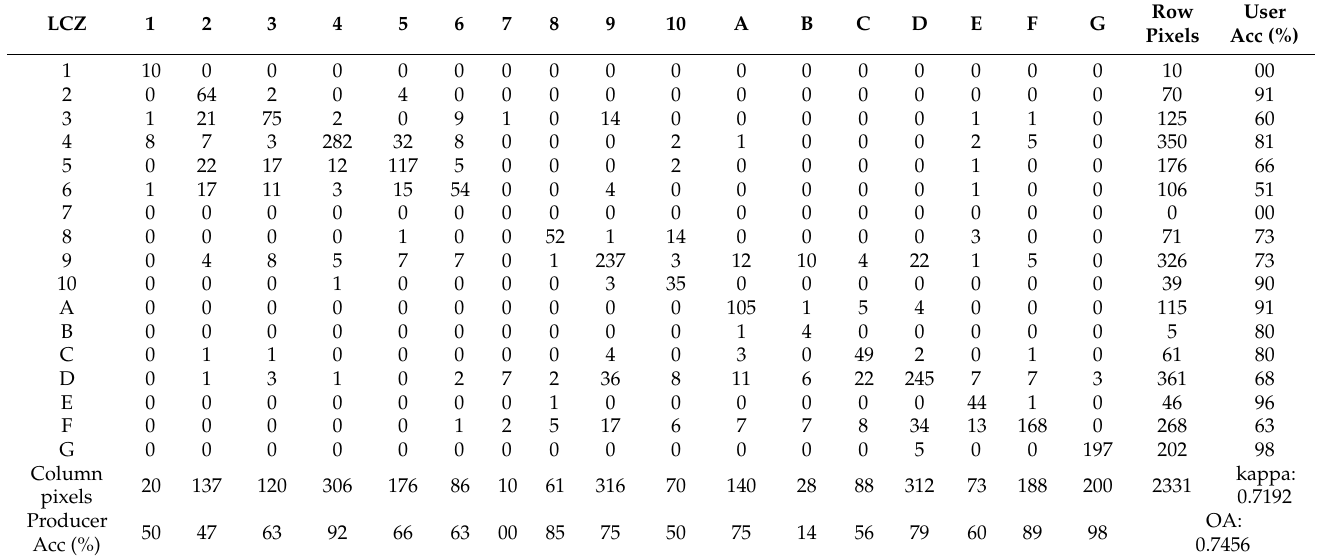
Table 3. Confusion matrix of LCZ classification in the main urban area and surrounding